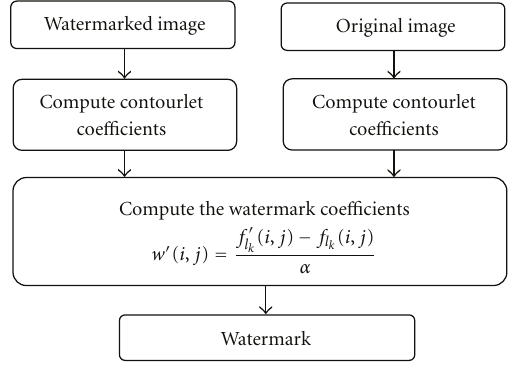
Figure 7: Extraction